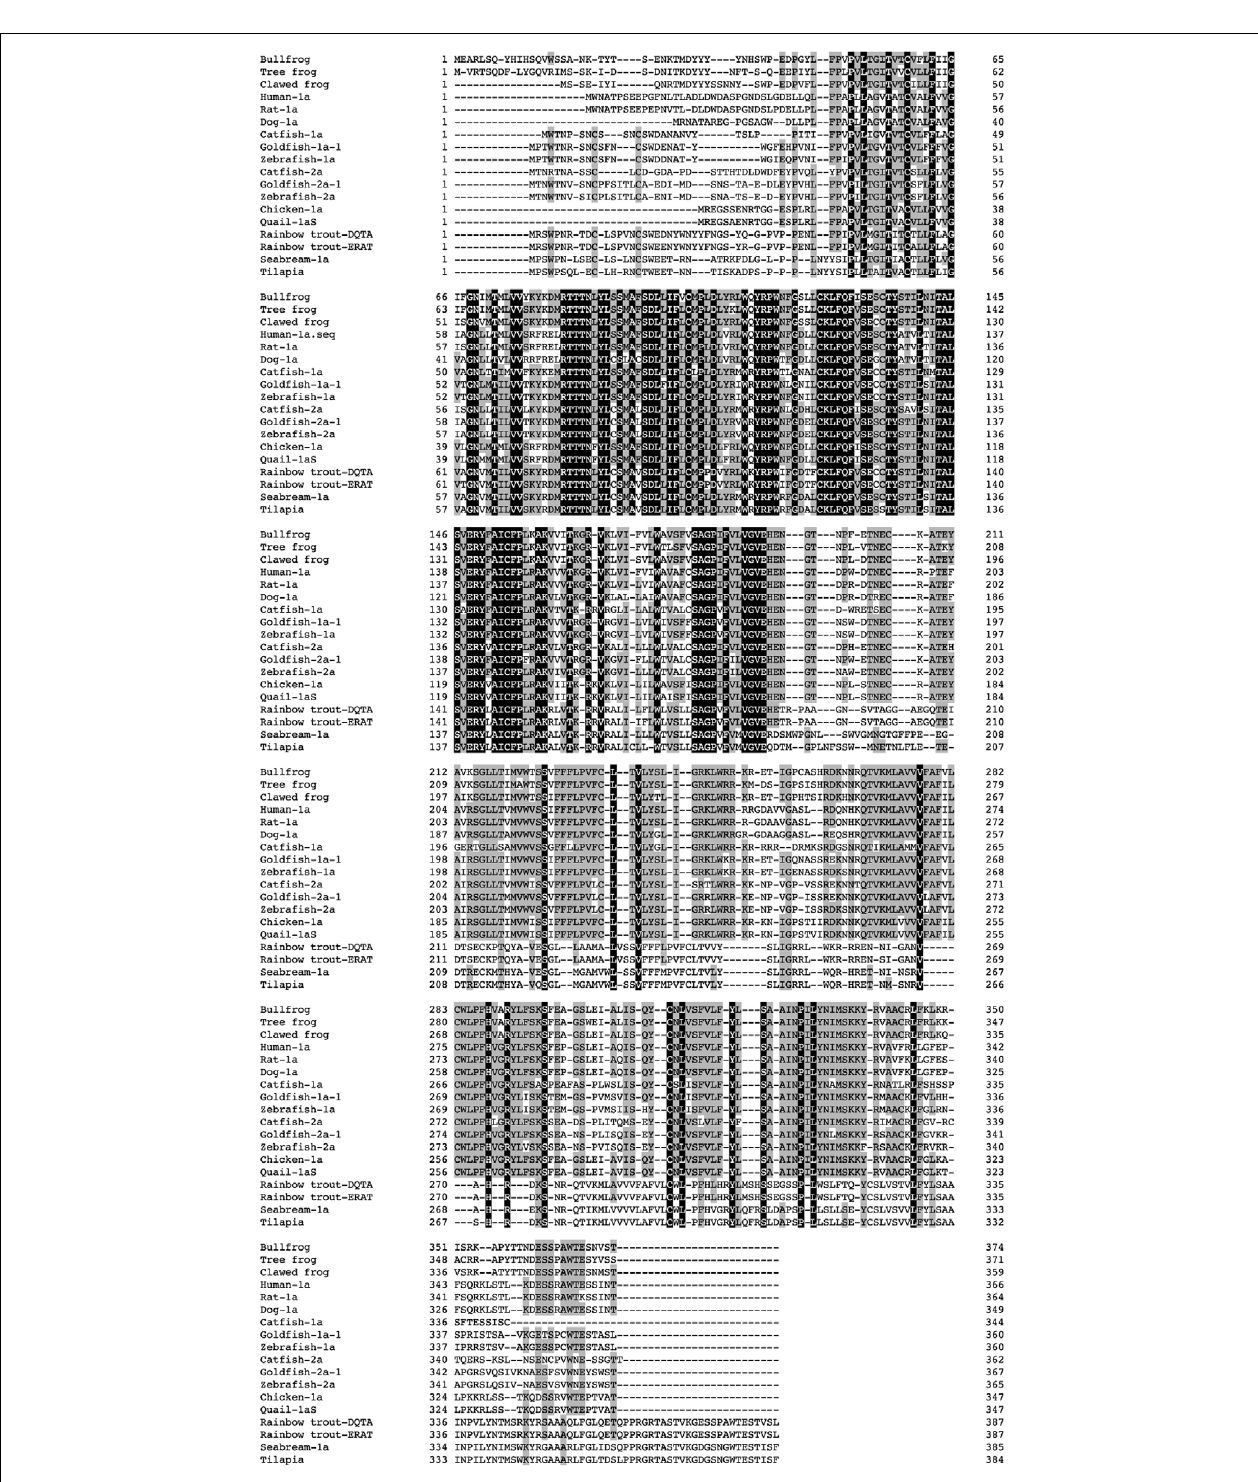
FIGURE 3 | Comparison of the amino acid sequence of frog GHS-Ra-like receptor with other GHS-Ra and GHSR1a-like receptors. The boxed letters indicate identical amino acids across all species, and the shaded letters show identical amino acids in more than half of the examined species. Amino acid sequences are available from the DDBJ/EMBL/GenBank databases: clawed frog (XM_002931572), human-1a (NM_198407), rat-1a (NM_032075), dog-1a